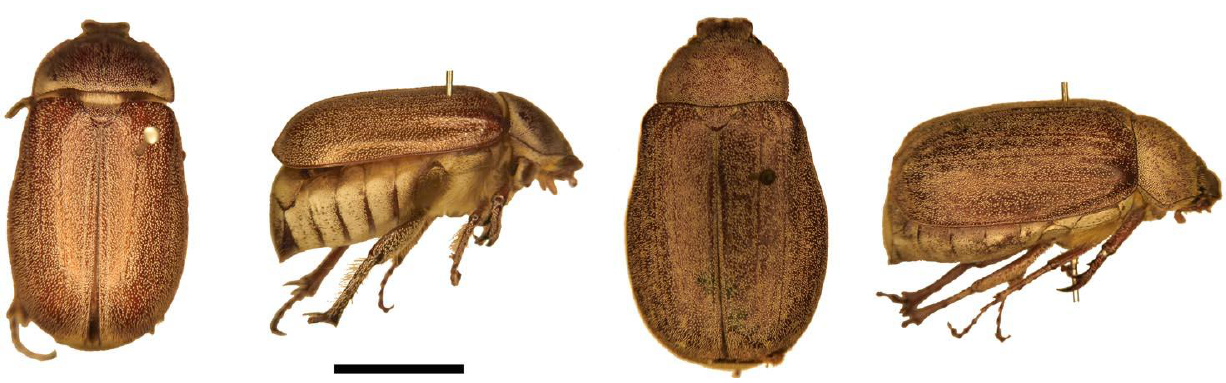
Figure 3. Adults of the two most individually damaging white grubs at the Juba Sugar Project, Somalia. Left , Cochliotis melolonthoides , and right , Brachylepis werneri